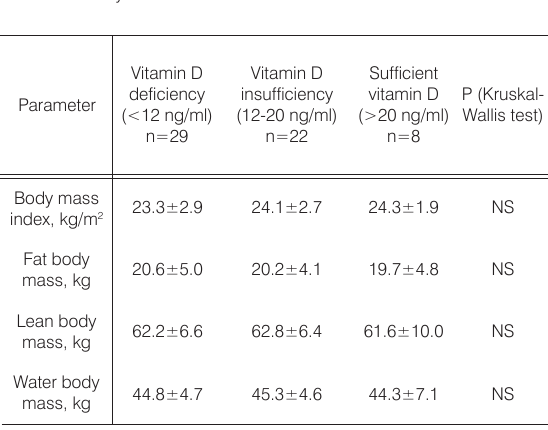
Table 5 Body composition in different subgroups of medical students by vitamin D concentration